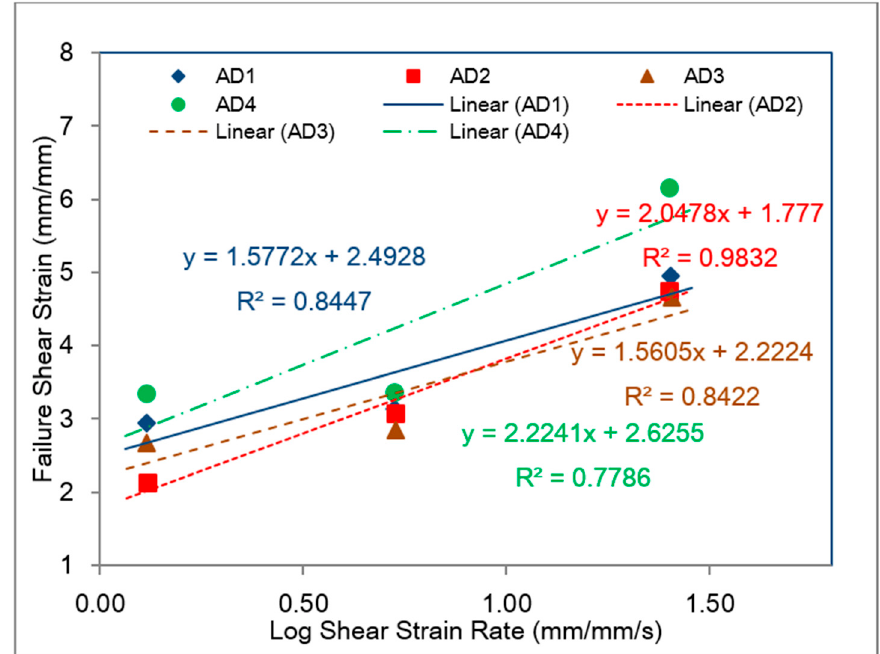
Figure 25. Variation of the failure shear strain as a function of shear strain rate during bonded single lap shear tests.